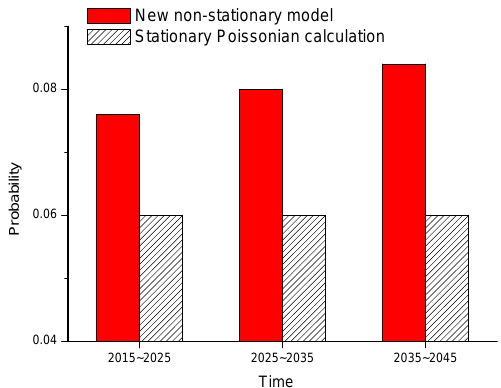
Figure 9. The earthquake probability in three 10-year periods Fig. 9. The earthquake probability in three 10-year periods for the example calculation, for the example calculation, with the earthquake return period of with the earthquake return period of 162 ± 50 years and other input data in Table 1 162 ± 50 years and other input data in Table 1.